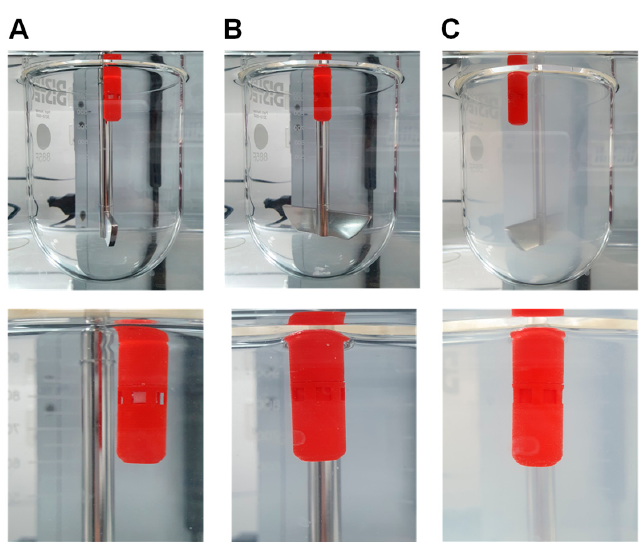
Figure 2. Gastroretentive sustained release drug delivery system immediately after putting in the dissolution with the windows open, i.e., open phase ( A ), with the windows closed after the RDT disintegrated, i.e., closed phase ( B ), and after the completion of drug release ( C ).